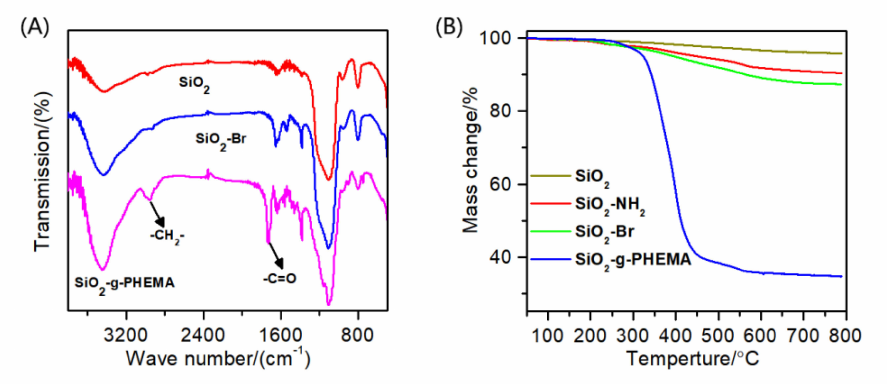
Figure 2. ( A ) The FTIR spectra of SiO 2 , SiO 2 -NH 2 , and the SiO 2 - g -PHEMA NPs; ( B ) the TGA curves of SiO 2 , SiO 2 -NH 2 , SiO 2 -Br, and the SiO 2 - g -PHEMA NPs. The TGA curves of SiO 2 , SiO 2 -NH 2 , SiO 2 -Br, and the SiO 2 - g -PHEMA NPs are